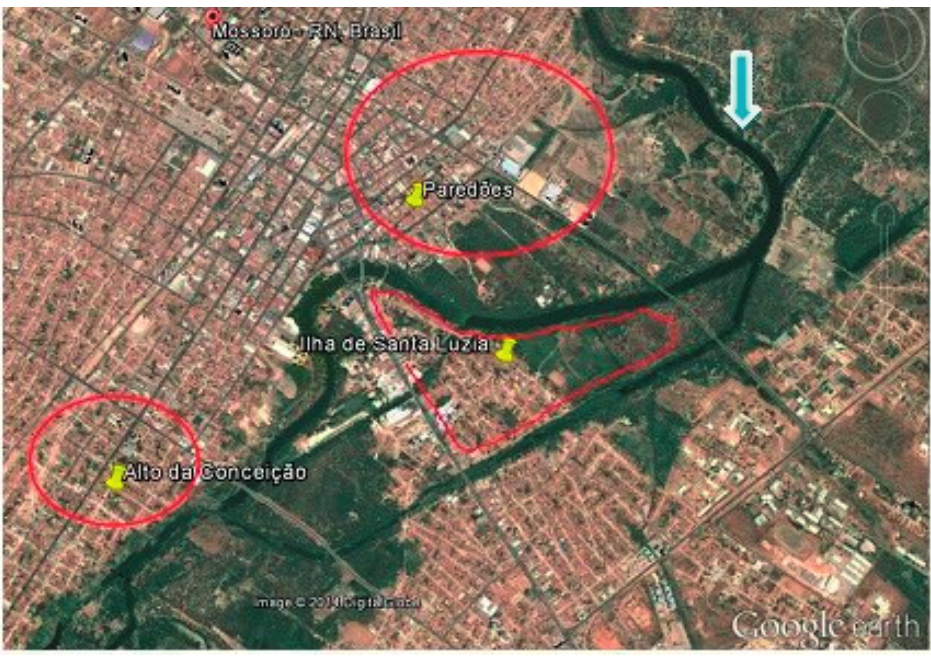
Figure 1. Location of neighborhoods with flood risk (indicated in red) near the Mossoró River (direction of flow indicated by arrow) in the city of Mossoró, State of Rio Grande do Norte. Source: Google Earth—2014, adapted by Amorim,